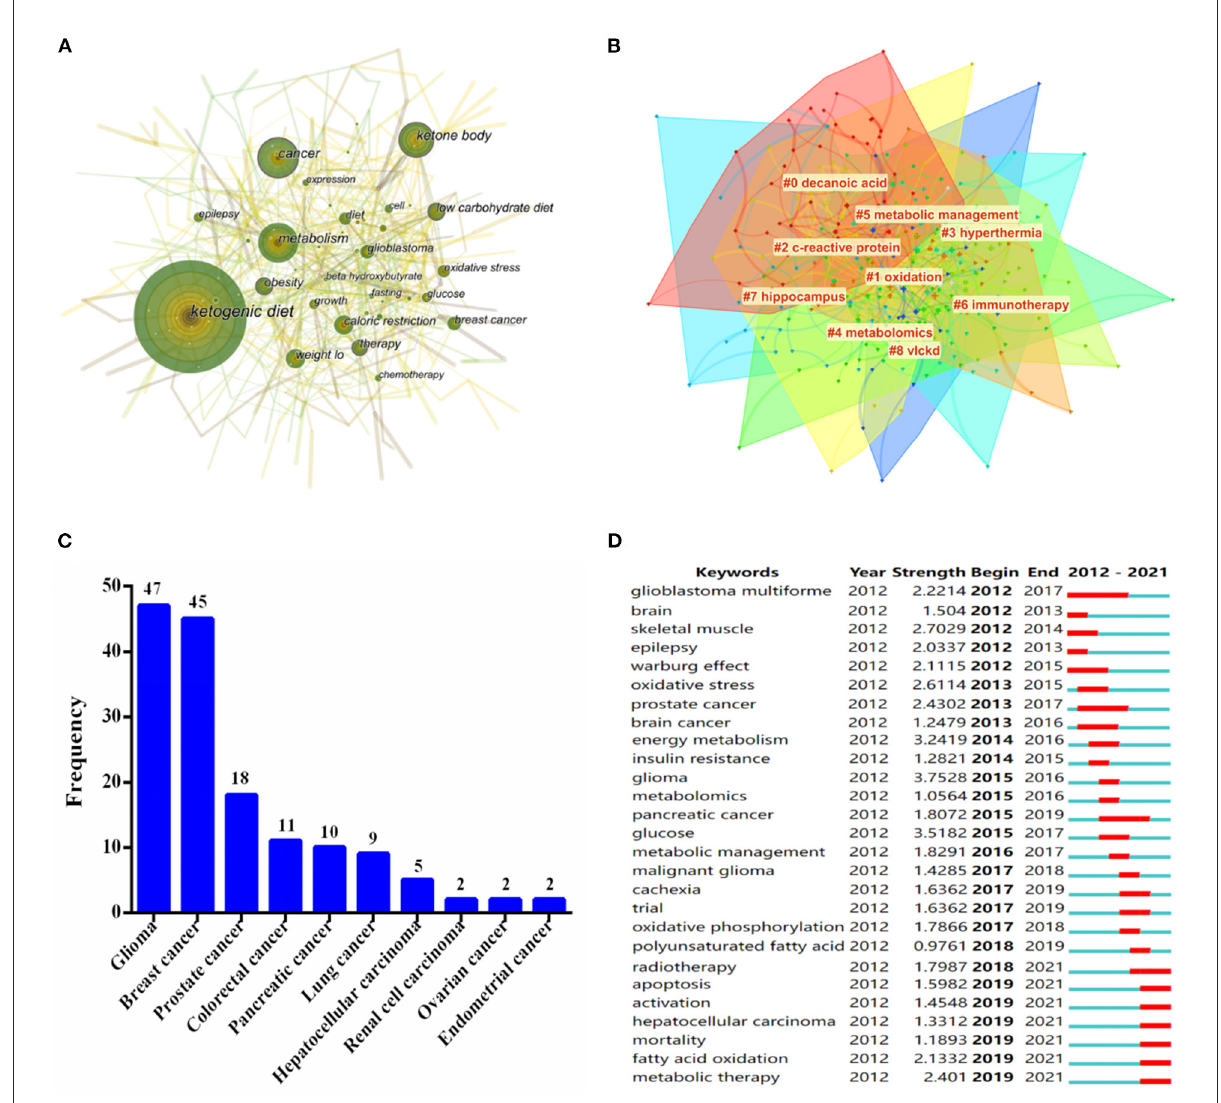
FIGURE6 (A) Map of keywords occurrence in the field of KD on cancer research from 2012 to 2021. (B) The cluster of keywords in the field of KD on cancer research. The different colors mean different clusters. (C) Top 10 cancer types in the field of KD on cancer research. (D) Keywords with periods of the strongest burst from 2012 to 2021 among the top 25 burst keywords in publications in the field of KD on cancer